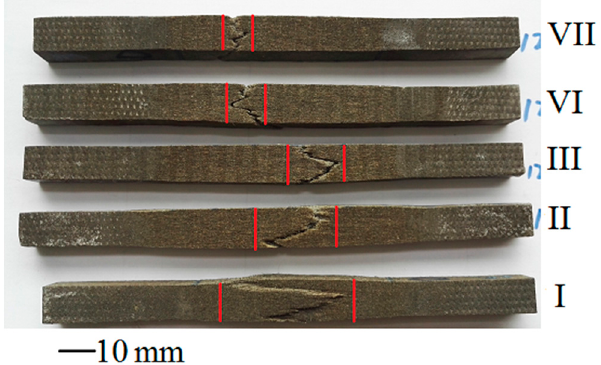
Figure 4. Macrograph of y - z plane of the fractured samples.